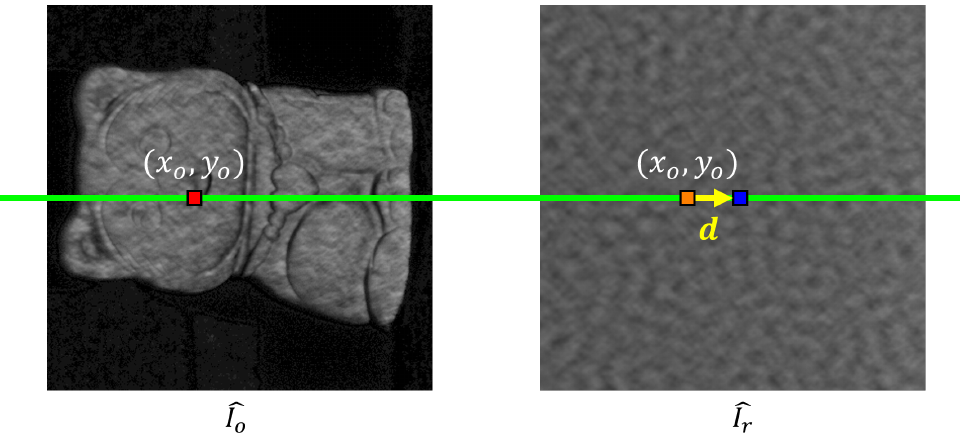
Figure 1. The definition of the disparity in this research. The disparity d is the pixel coordinate difference between the point of interest (POI) on ˆ I o and its corresponding point on ˆ I r found using SGM. (Red point: POI, blue point: corresponding point, green line: pre-computed epipolar line through absolute phase constraints, orange point: point on ˆ I r with the same pixel coordinate as POI, yellow arrow: disparity vector d